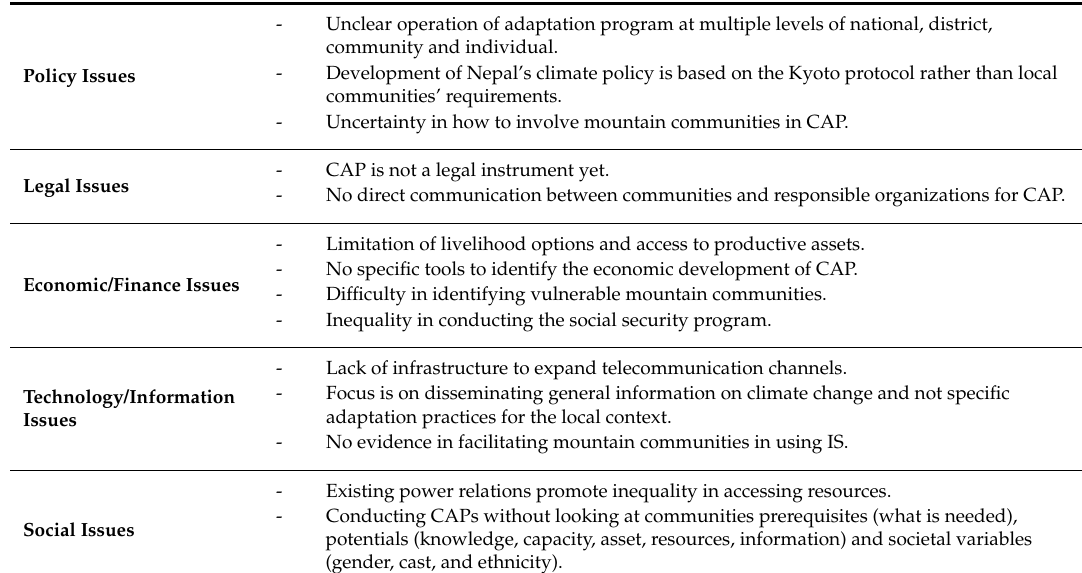
Table 1. Limitations of current Community-based Adaptation Programs